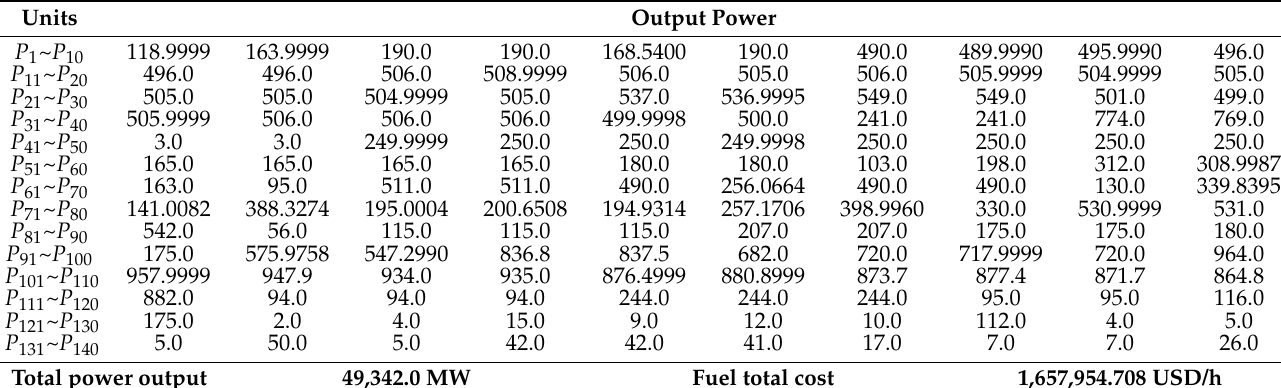
Table 13. The best decision variables obtained for Case D by the proposed G-SCNHGWO.